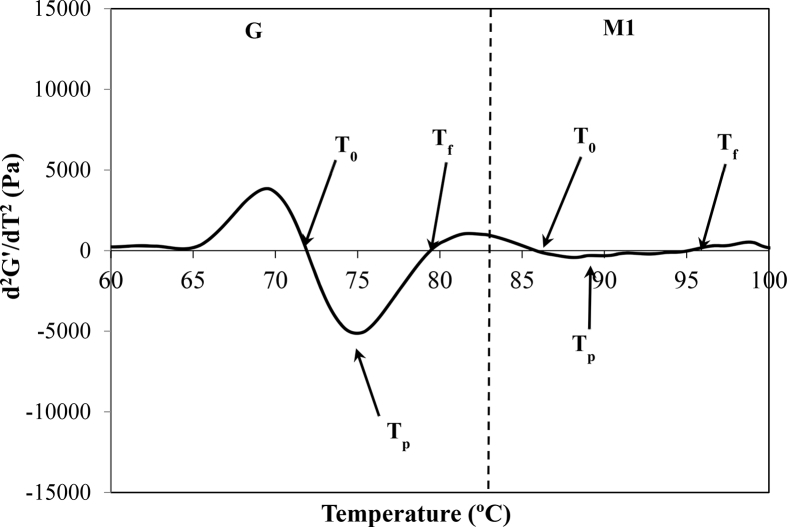
Second derivative of G′(T) (d2G'/dT2) for DMTA experimental data of CD, G and M1 transition.